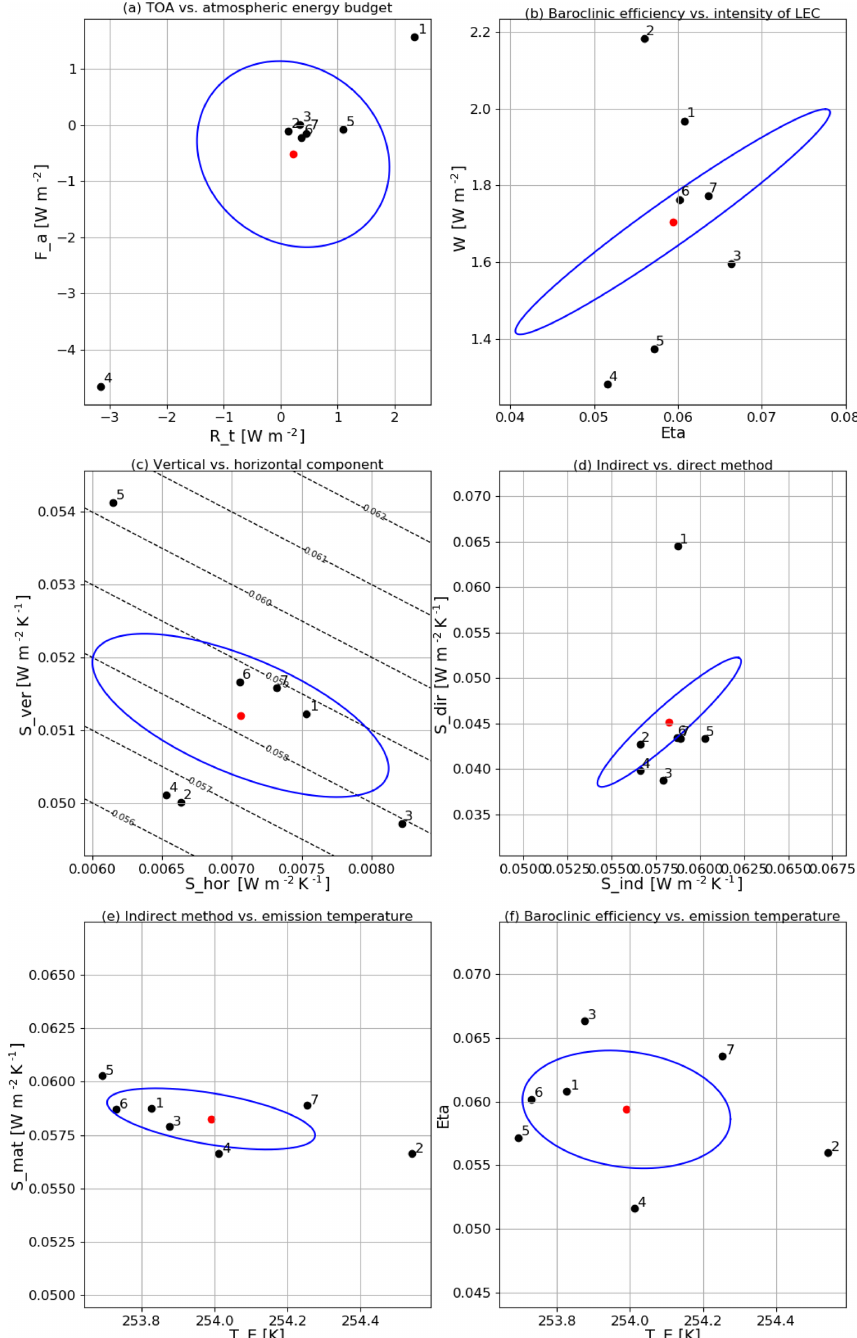
Figure 10. Multi-model ensemble scatter plots from the piC scenario for (a) atmospheric energy budget vs. TOA energy budget (Wm − 2 ), (b) baroclinic efficiency vs. LEC intensity (Wm − 2 ), (c) vertical component of the material entropy production vs. vertical component (together with isolines of total material entropy production with the indirect method) (Wm − 2 K), and (d) direct vs. indirect method for material entropy production (Wm − 2 K). Blue ellipses denote the σ standard deviation of the multi-model mean (denoted by the red dot). Model IDs are (1) BNU, (2) Can2, (3) IPSL-M, (4) MIR5, (5) MIR-C, (6) MPI-LR and (7)